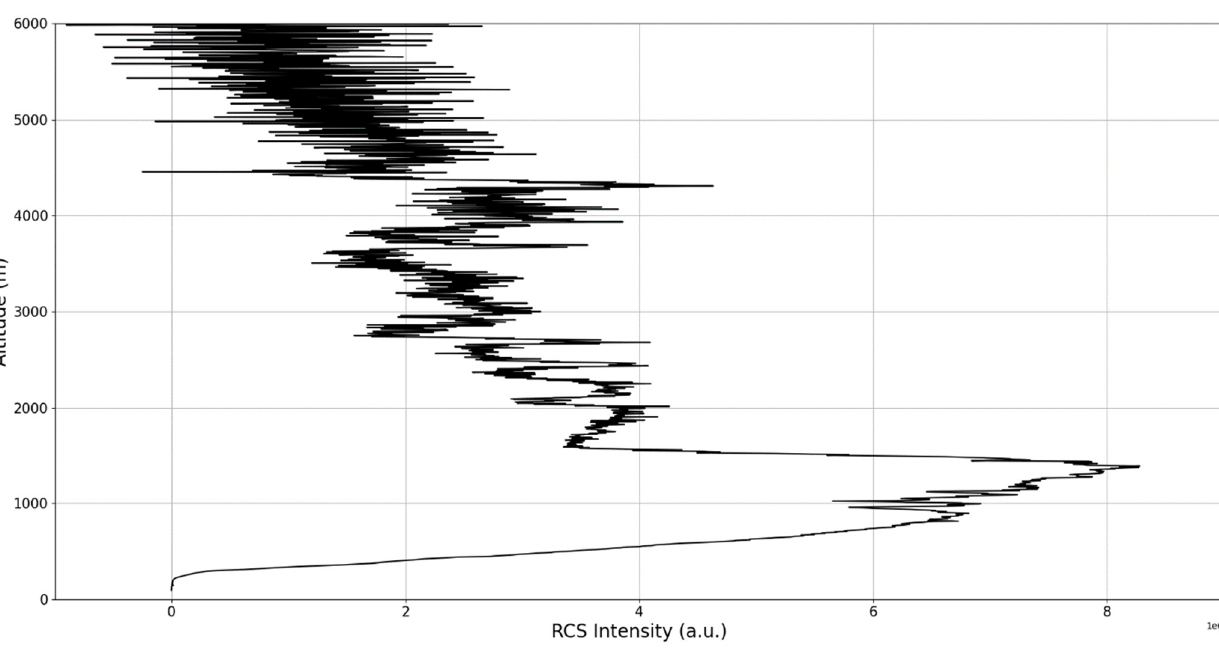
Figure 9. Zoomed-in RCS profile corresponding to point C.